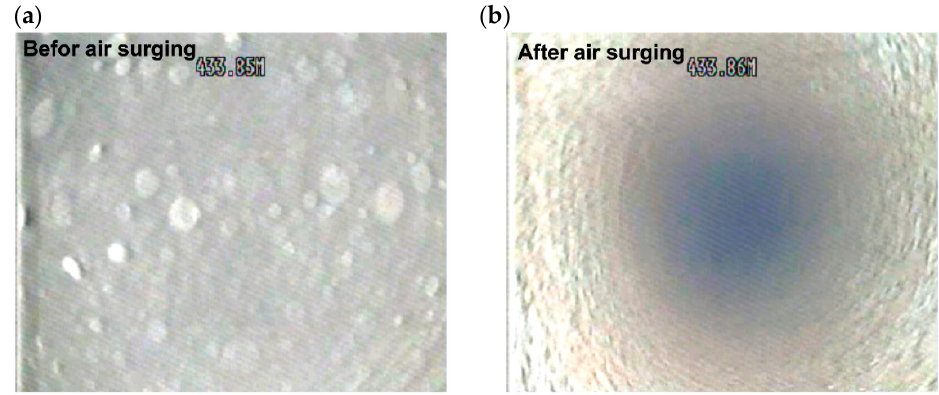
Figure 5. ( a ) A photo of the interior of the groundwater well before air surging, ( b ) a photo of the interior of the groundwater well after air